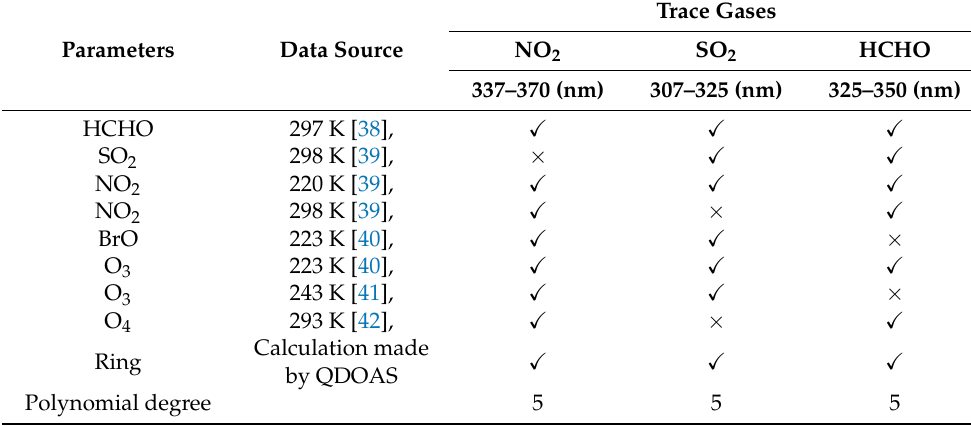
Table 1. Retrieval settings for trace gases spectral